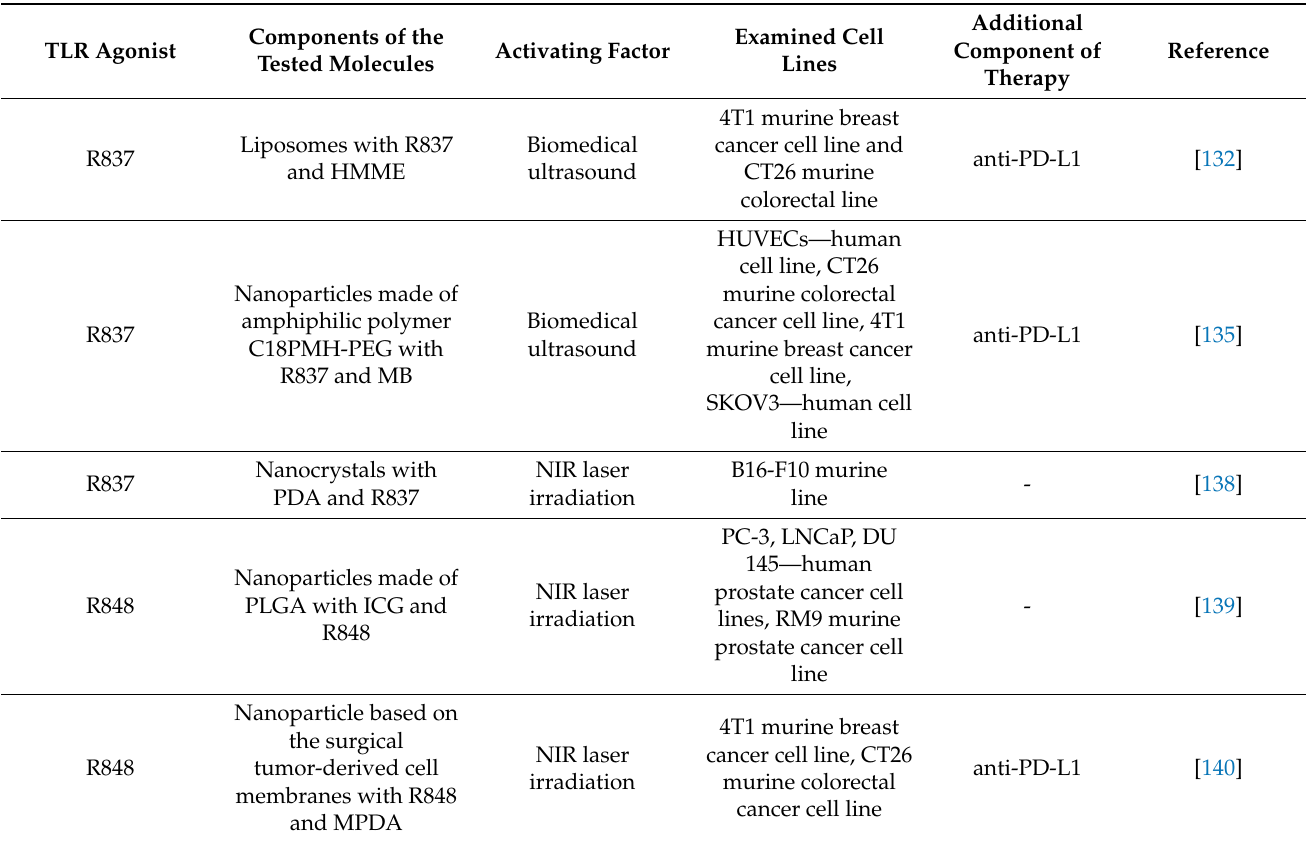
Table 2. Examples of studies using TLR agonists in combination with sonodynamic or photothermal